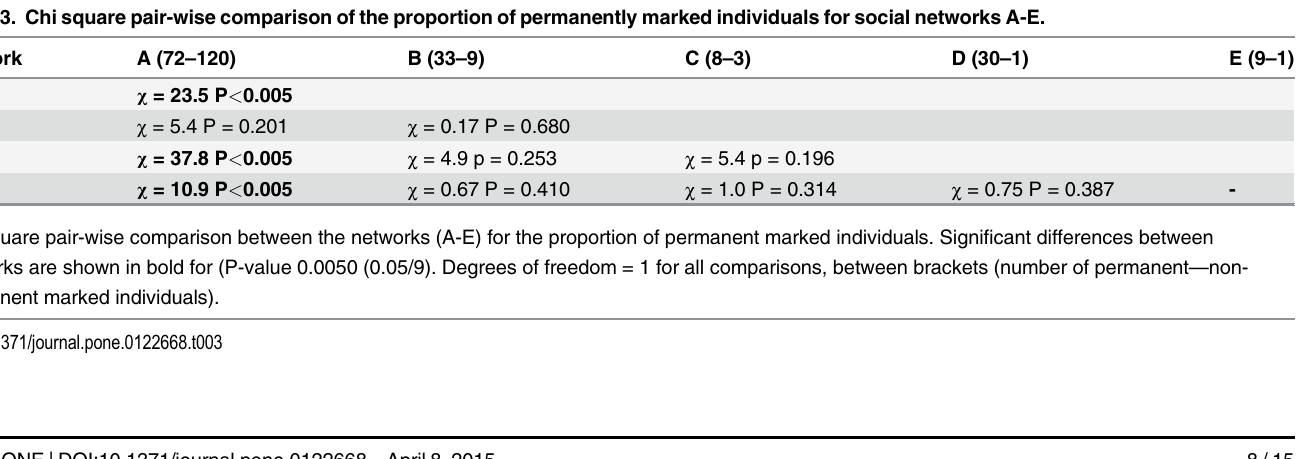
Table 3. Chi square pair-wise comparison of the proportion of permanently marked individuals for social networks A-E. Network